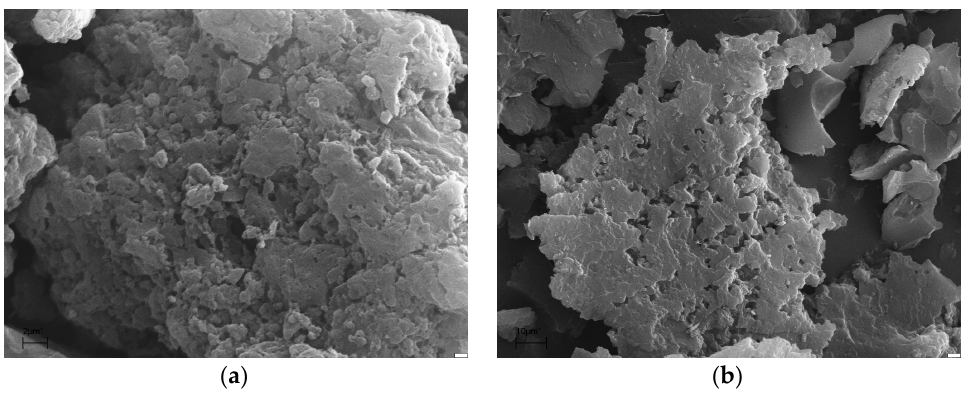
Figure 3. SEM micrographs of samples A6 ( a ) and A7 ( b ). Table 2. Textural parameters of samples A6 and A7.